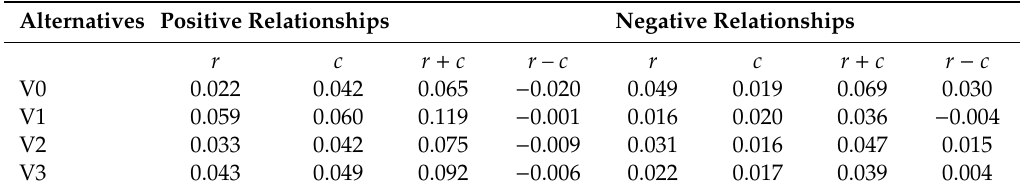
Table 3. Crisp values of total influence r , susceptibility c , engagement r + c and the role r – c for the analysed alternatives and the nature of the relationship.